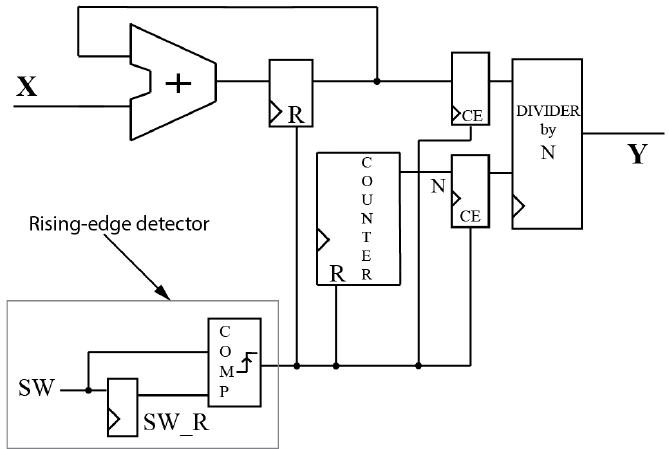
Figure 1. Digital schematic of the mathematical average (Mav) filter.